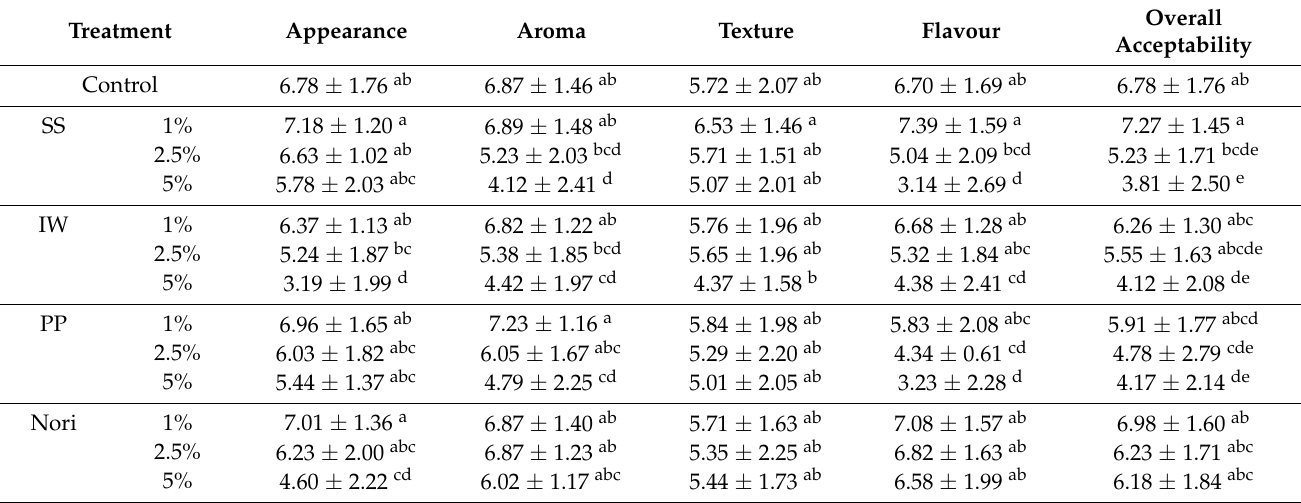
Table 5. Sensory (hedonic) scores of control sausage and sausages containing 1%, 2.5%, and 5% brown and red seaweed species.